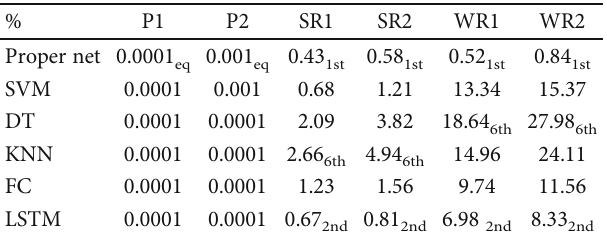
Table 6: The ARE of six methods.